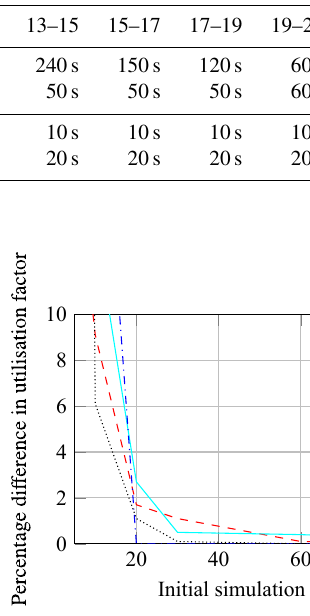
Figure 15. Initial transient behaviour of the wind turbine with a jacket substructure for different wind speeds. Percentage difference in the fatigue damage compared to the “converged” value (120s).